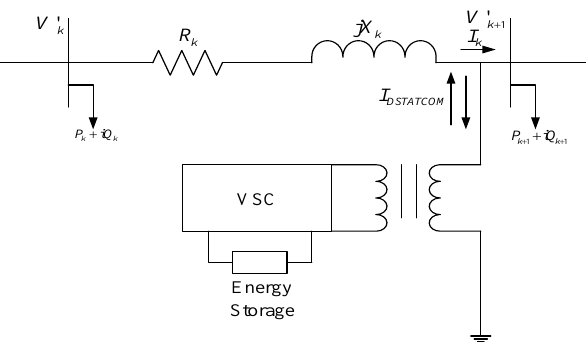
Figure 5. Installation of DSTATCOM in ( k + 1) th bus of the system to be proposed.